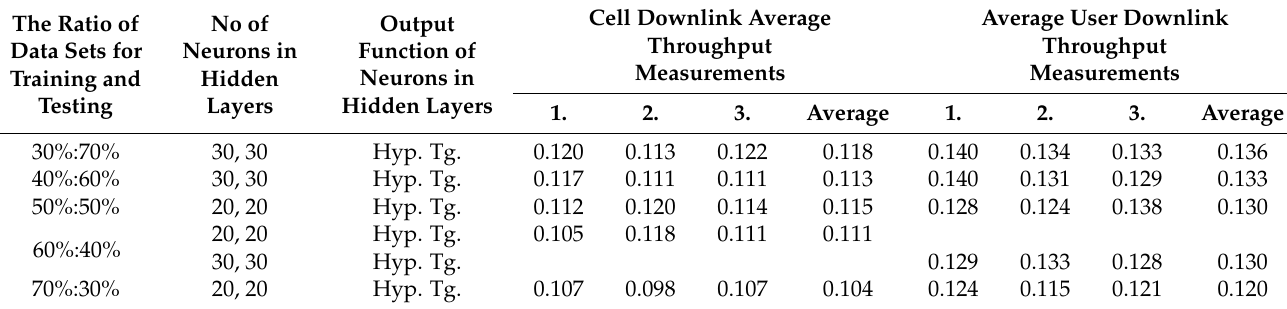
Table 8. Least average values of RE by examined ratios of training data set and test data set.